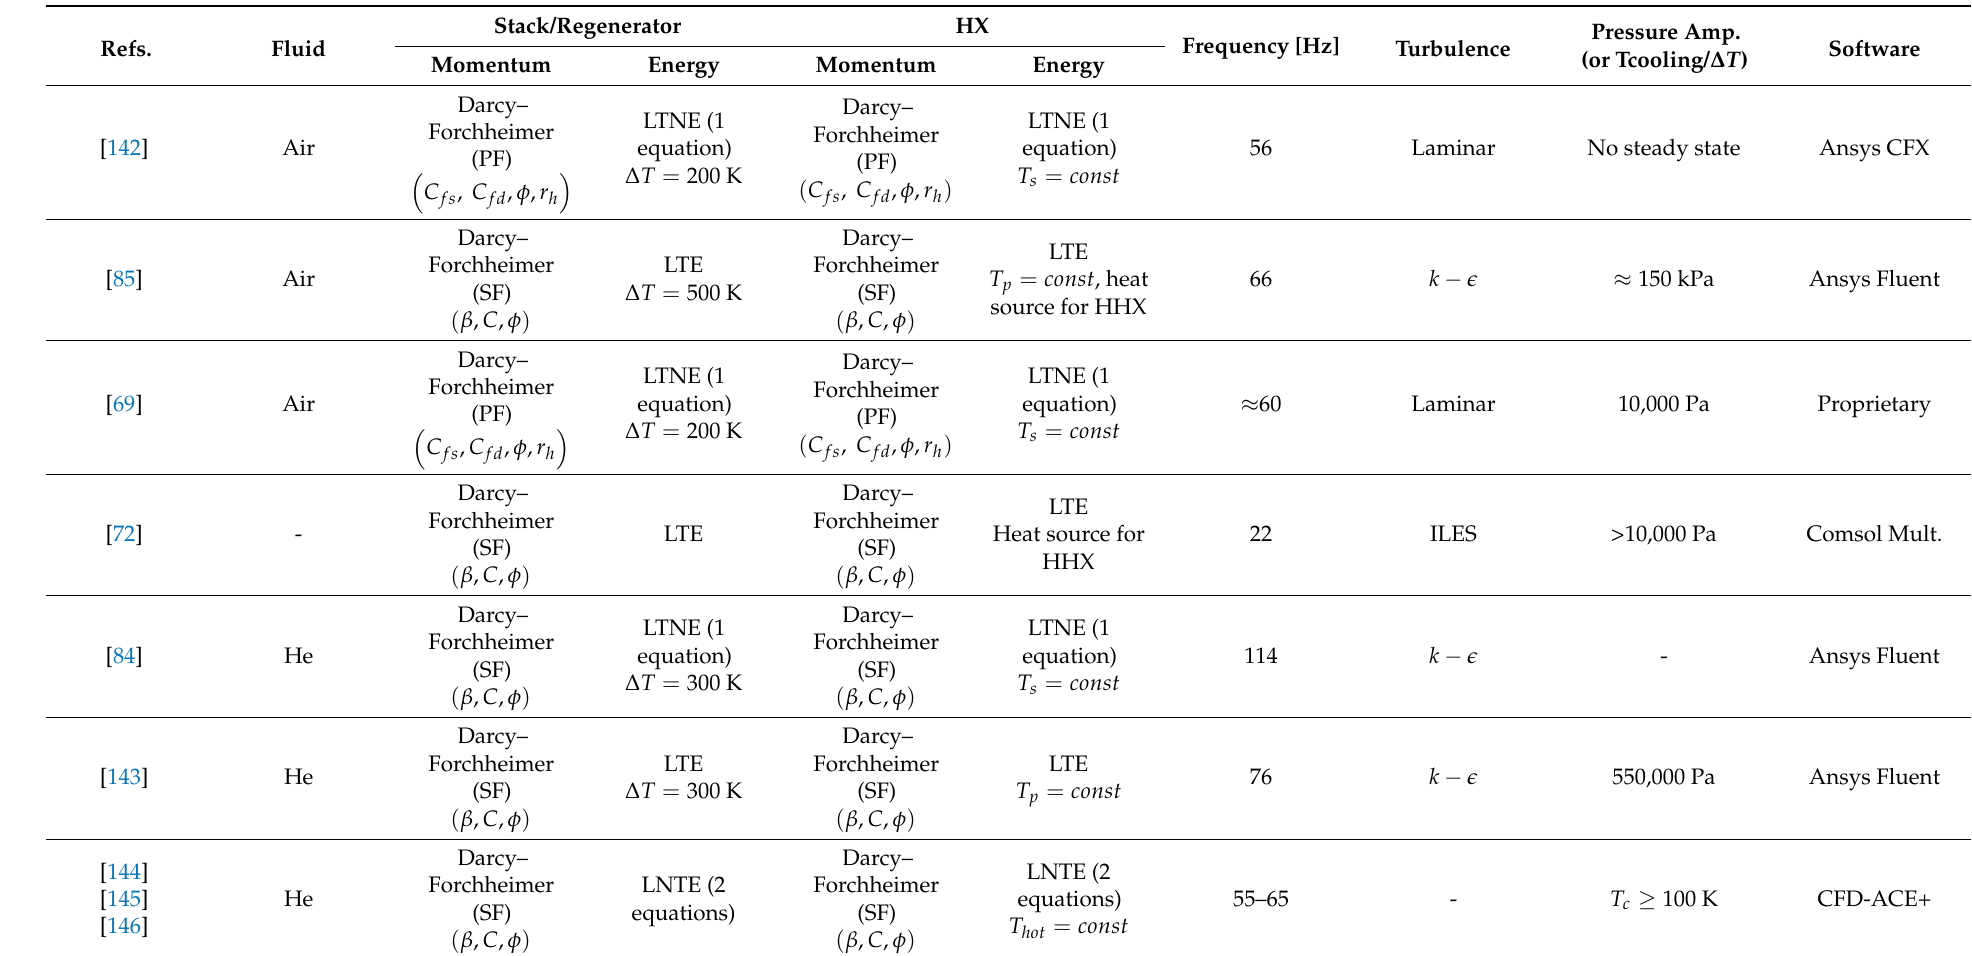
Table 6. Detailed characteristics of full device simulations at the macroscopic scale.